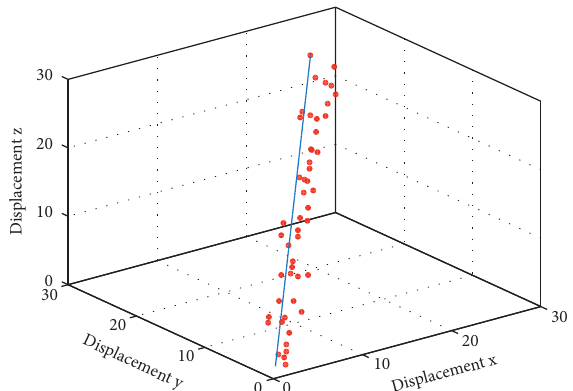
Figure 6: Three-dimensional scatter fitting of motor wind speed curve.